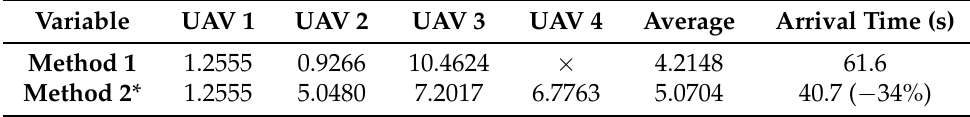
Table 5. Flight distance [m] of the four UAVs in the formation transformation process.